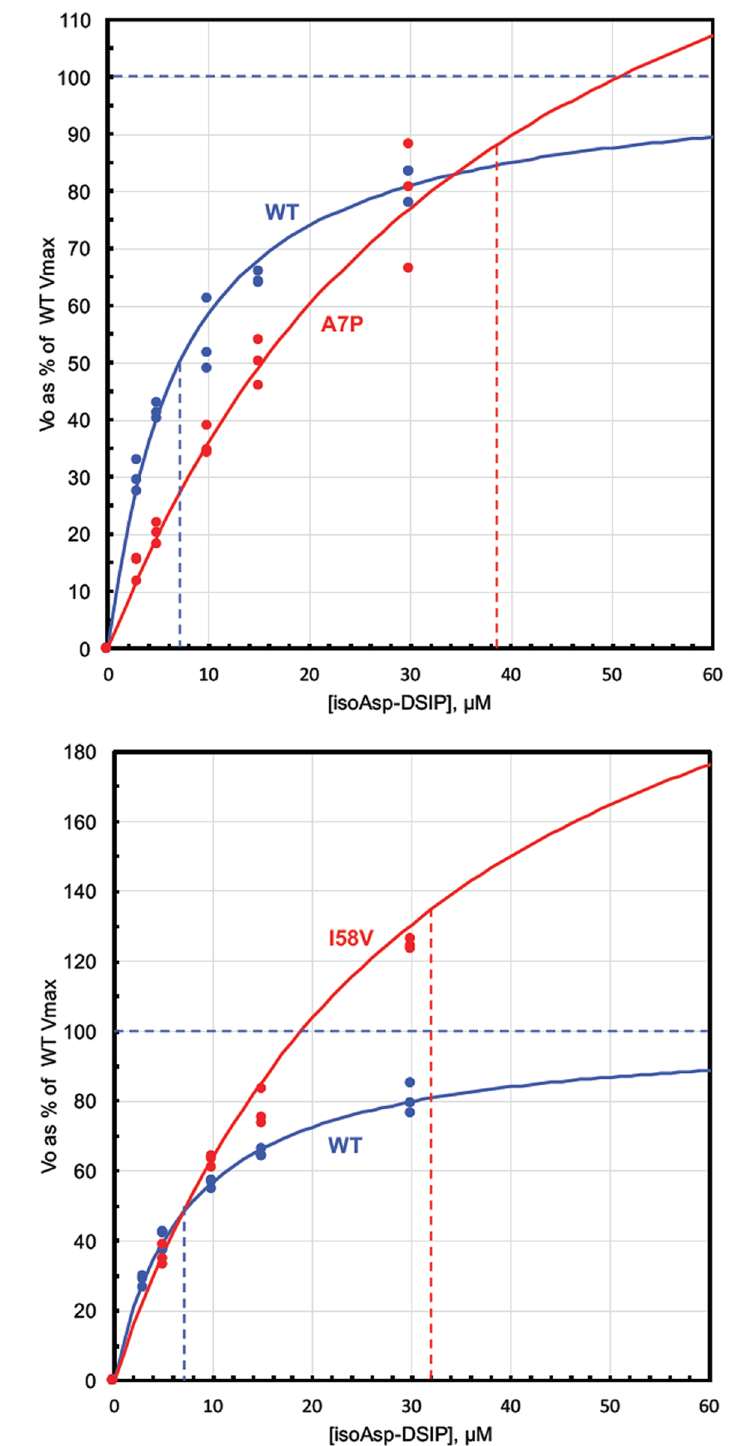
Fig 5. Determination of kinetic constants for variants A7P and I58V using isoAsp-DSIP as methyl acceptor. All assays were carried out in triplicate as described in Materials and methods. For WT (both panels) and A7P (top panel), isoAsp-DSIP was varied over the range of 3–30 μM. For I58V (bottom panel), isoAsp-DSIP was varied over the range of 5–100 μM, but data points for 100 μM are not shown. Initial rates measured at each concentration of isoAsp-DSIP are superimposed on a curve defined by the Michaelis-Menten equation using values of Vmax and Km calculated